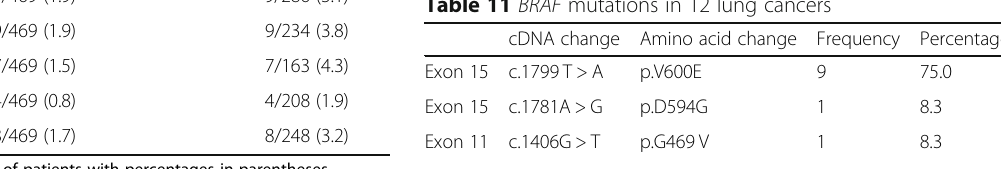
Table 10 Frequency of oncogenic driver mutation in our study cohort Study population (n = 469)